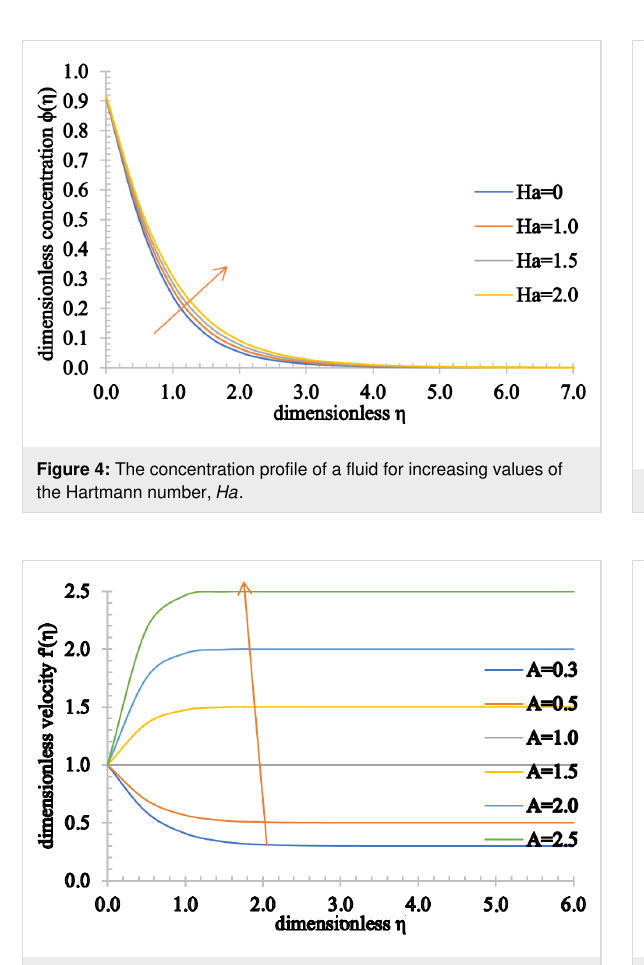
Figure 8: The velocity profile for increasing values of β .